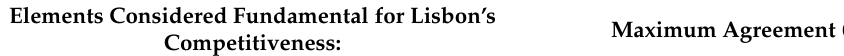
Table 11. Summary of the dimensions considered validated in the first round of Delphi. Source: Elaborated by the